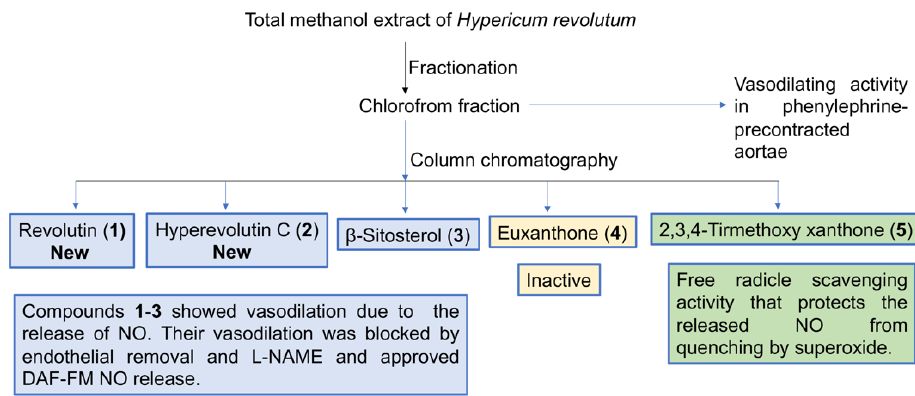
Figure 8. Diagrammatic sketch summarizing the study design.